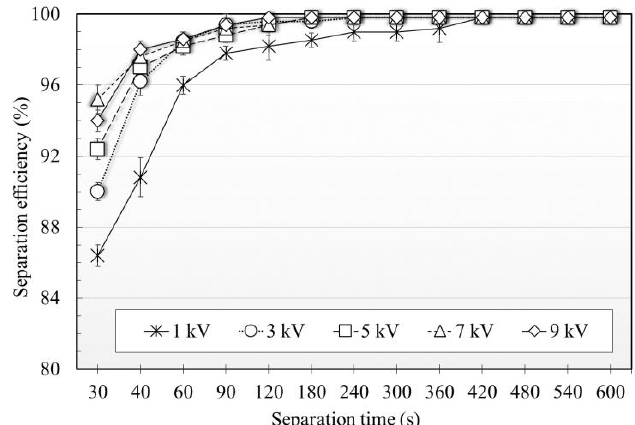
Figure 13. Effect of separation time at various applied AC voltages on the separation efficiency of the EDS process using iron (Fe) point-to-point electrodes with a vertical distance between electrodes of 3